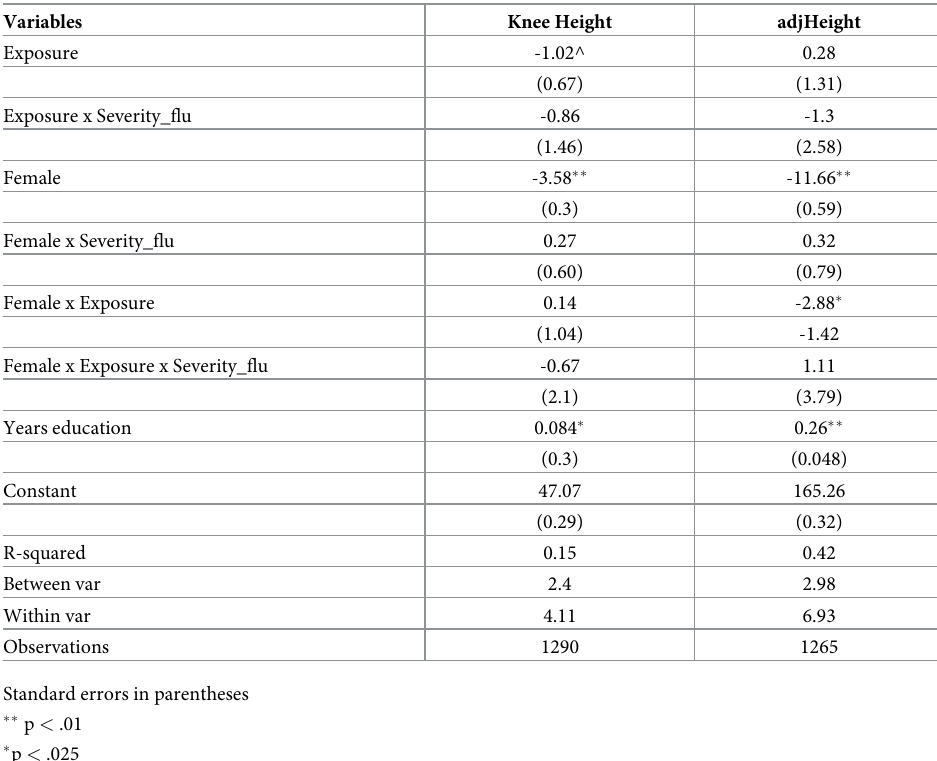
Table 4. Models with flu